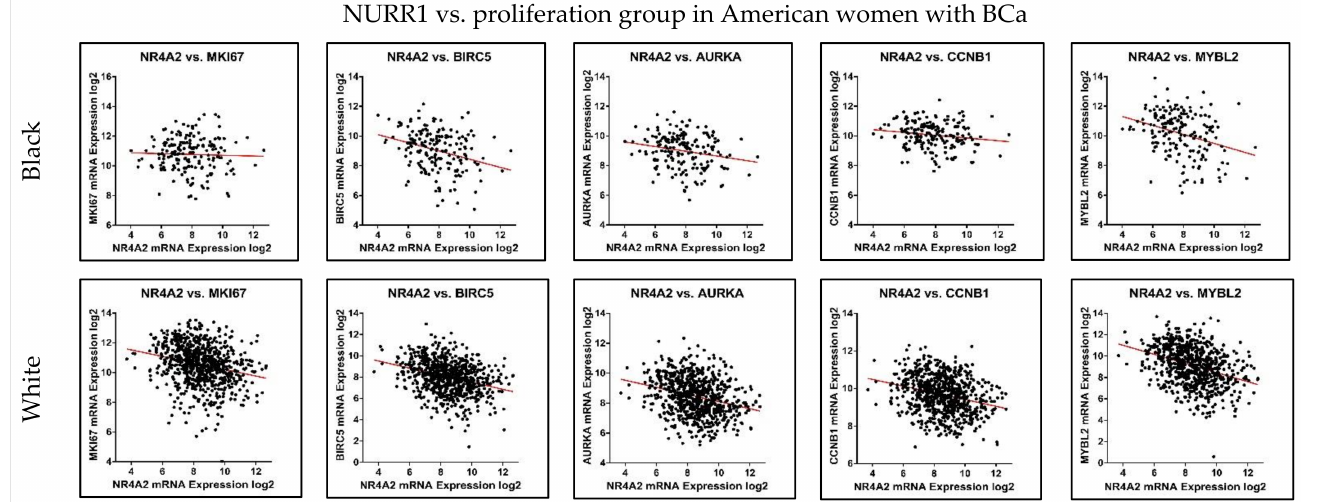
Figure 5. NURR1 expression is negatively correlated with Oncotype DX proliferation group. The correlation trend of NURR1 with proliferation markers was found to be negative in both Black ( Top row ) and White ( Bottom row ) BCa women. The X and Y -axis represent the log2 of mRNA expression of RSEM batch normalized from illumina HiSeq-RNASeqV2.